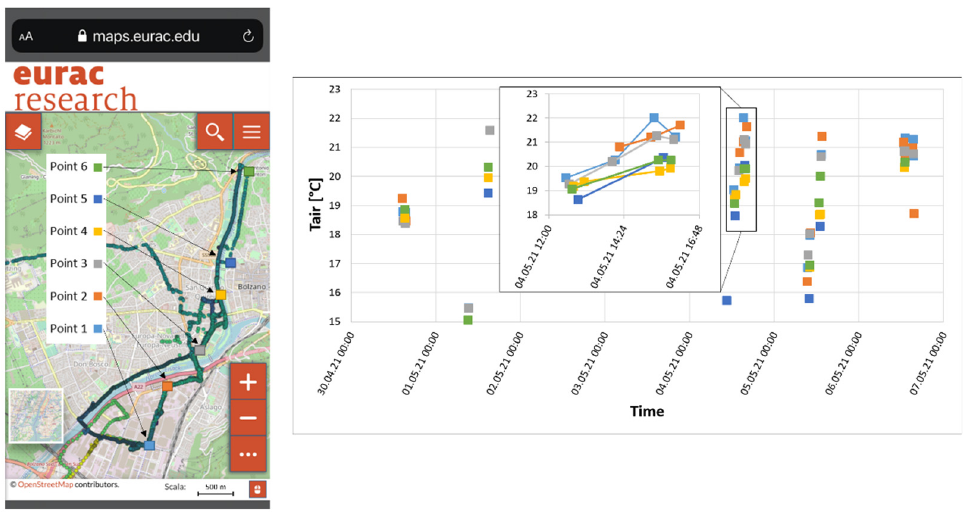
Figure 9. Filtering of the T air data acquired by the mobile monitoring prototypes at relevant points distributed along the city of Bolzano. The time series obtained are shown in the plot on the right. An inset shows the temperature daily trends at the specific acquisition points.